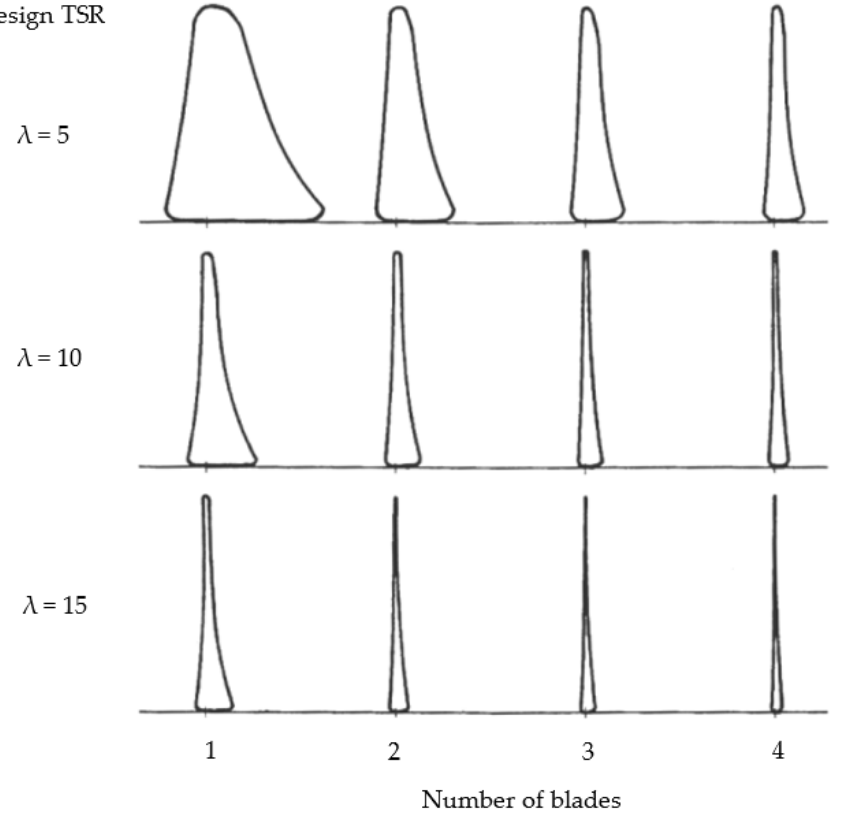
Figure 9. HAWT optimal blade shape. Adapted from Ref. [87].